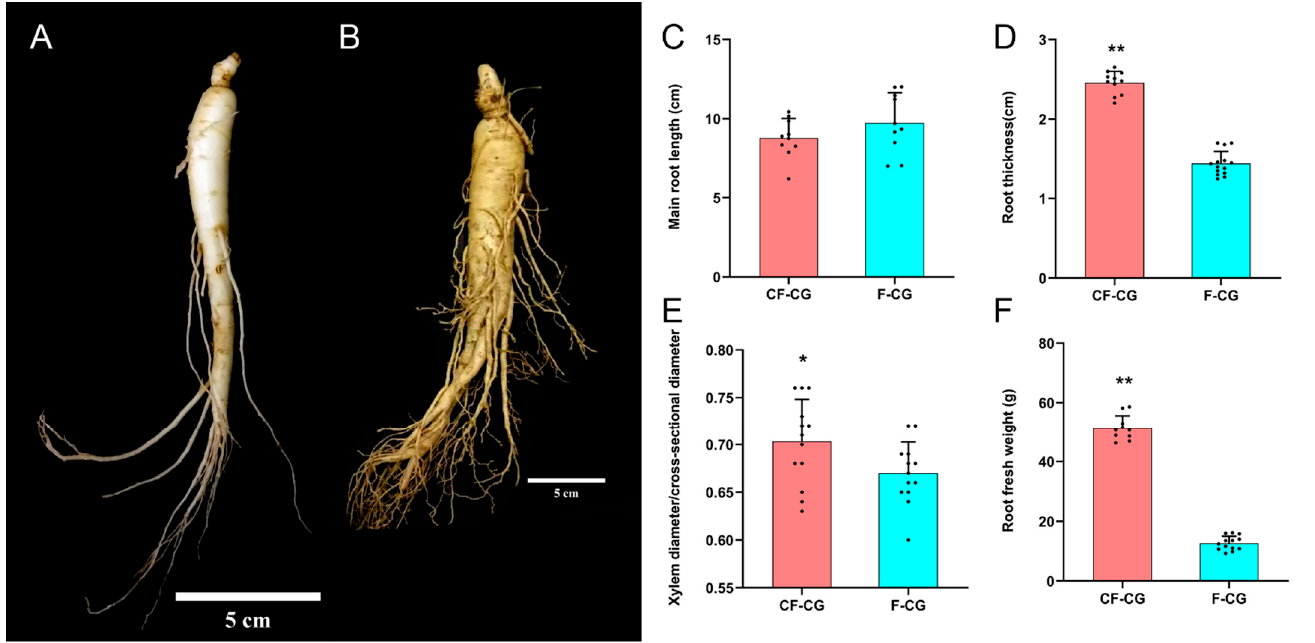
Figure 1. Growth and development of taproots of garden ginseng in different regions. ( A ): Garden ginseng cultivated in farmland (F-CG); ( B ): garden ginseng cultivated in deforested land (CF-CG), with the linear scale = 5 cm. ( C ): main root length; ( D ): main root thickness; ( E ): ratio of xylem diameter to cross-sectional diameter; ( F ): fresh weight of root (points in the figure represent individual values, and error bars represent standard errors; n = 12 (* p < 0.05; ** p > 0.01; the significance of the difference was analyzed using t -test).